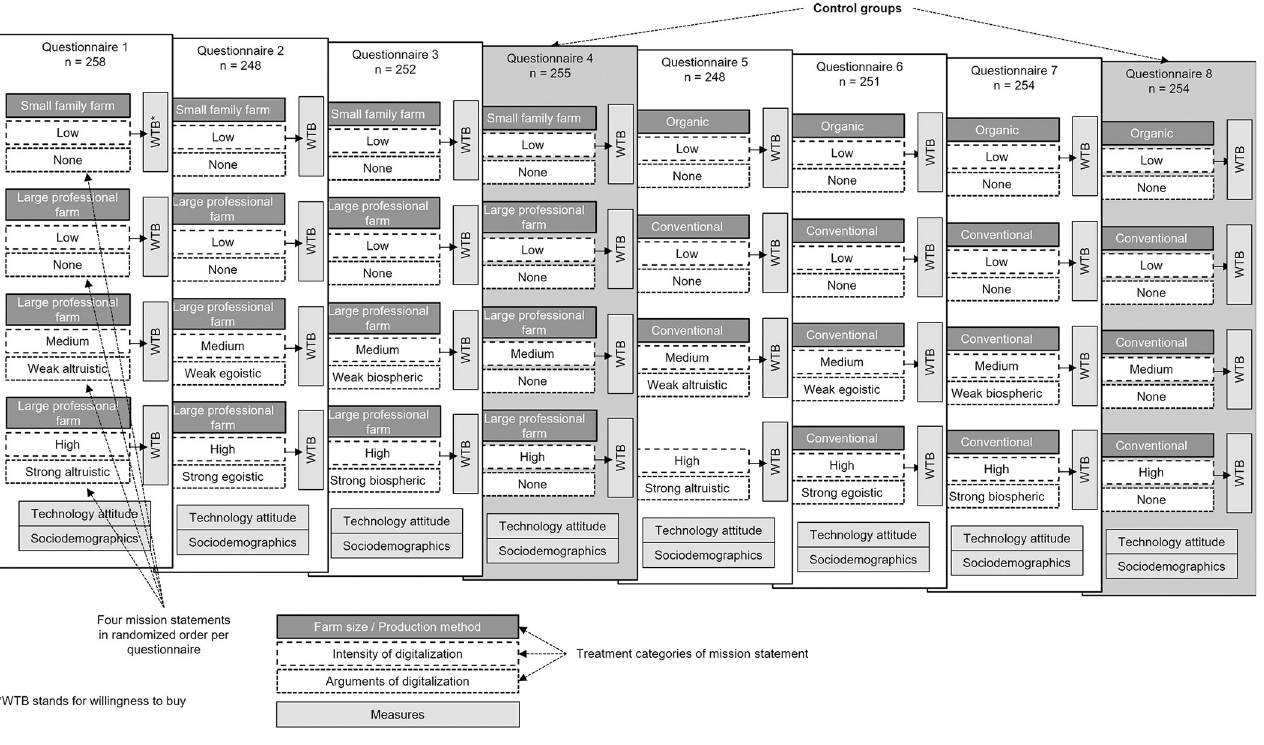
Fig 1. Questionnaire